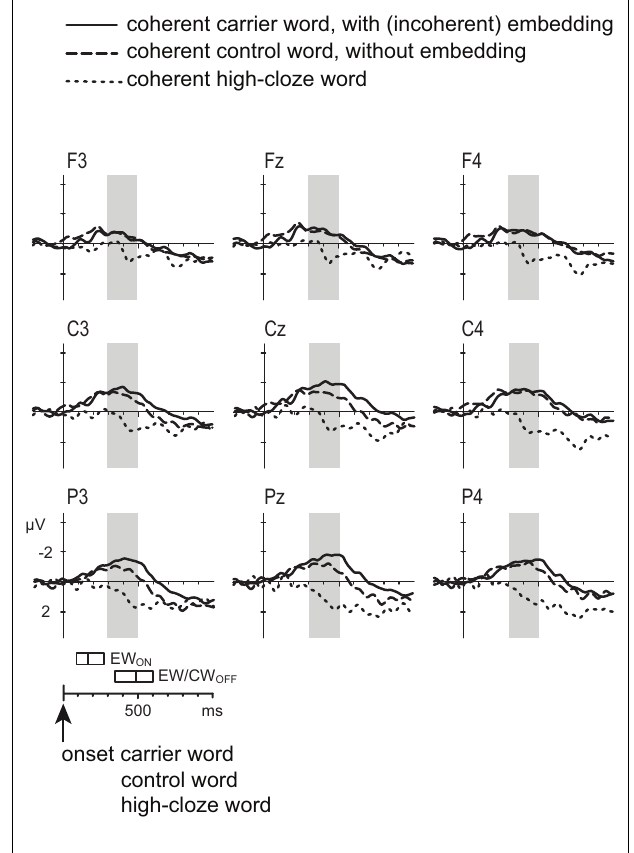
FIGURE 2 | Grand average event-related potentials from nine scalp sites to coherent carrier words with final embeddings (solid line), coherent control words without embeddings (dashed line), and to coherent high-cloze words (dotted line), after baseline correction in the 200-ms prestimulus interval, time-locked to the onset of the carrier/control words. The bars in the lower left corner indicate the onset of the embedded words (EW ON ), the offset of the embedded words (EW OFF ), and the offset of the carrier words (CW OFF